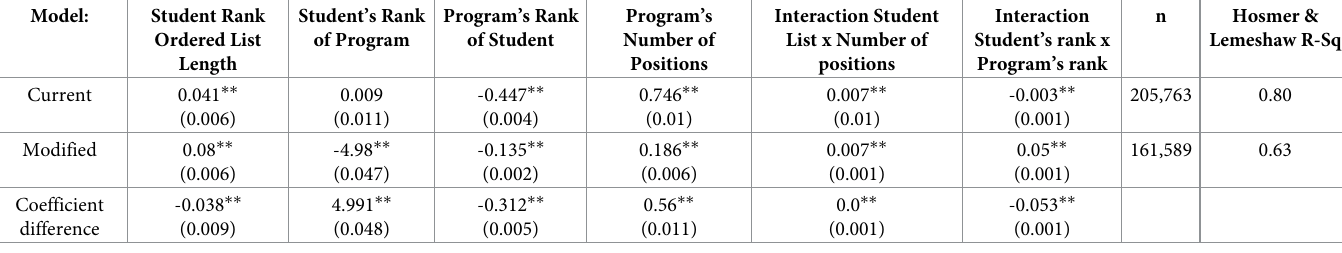
Table 2. Multiple logistical regression models of matching.